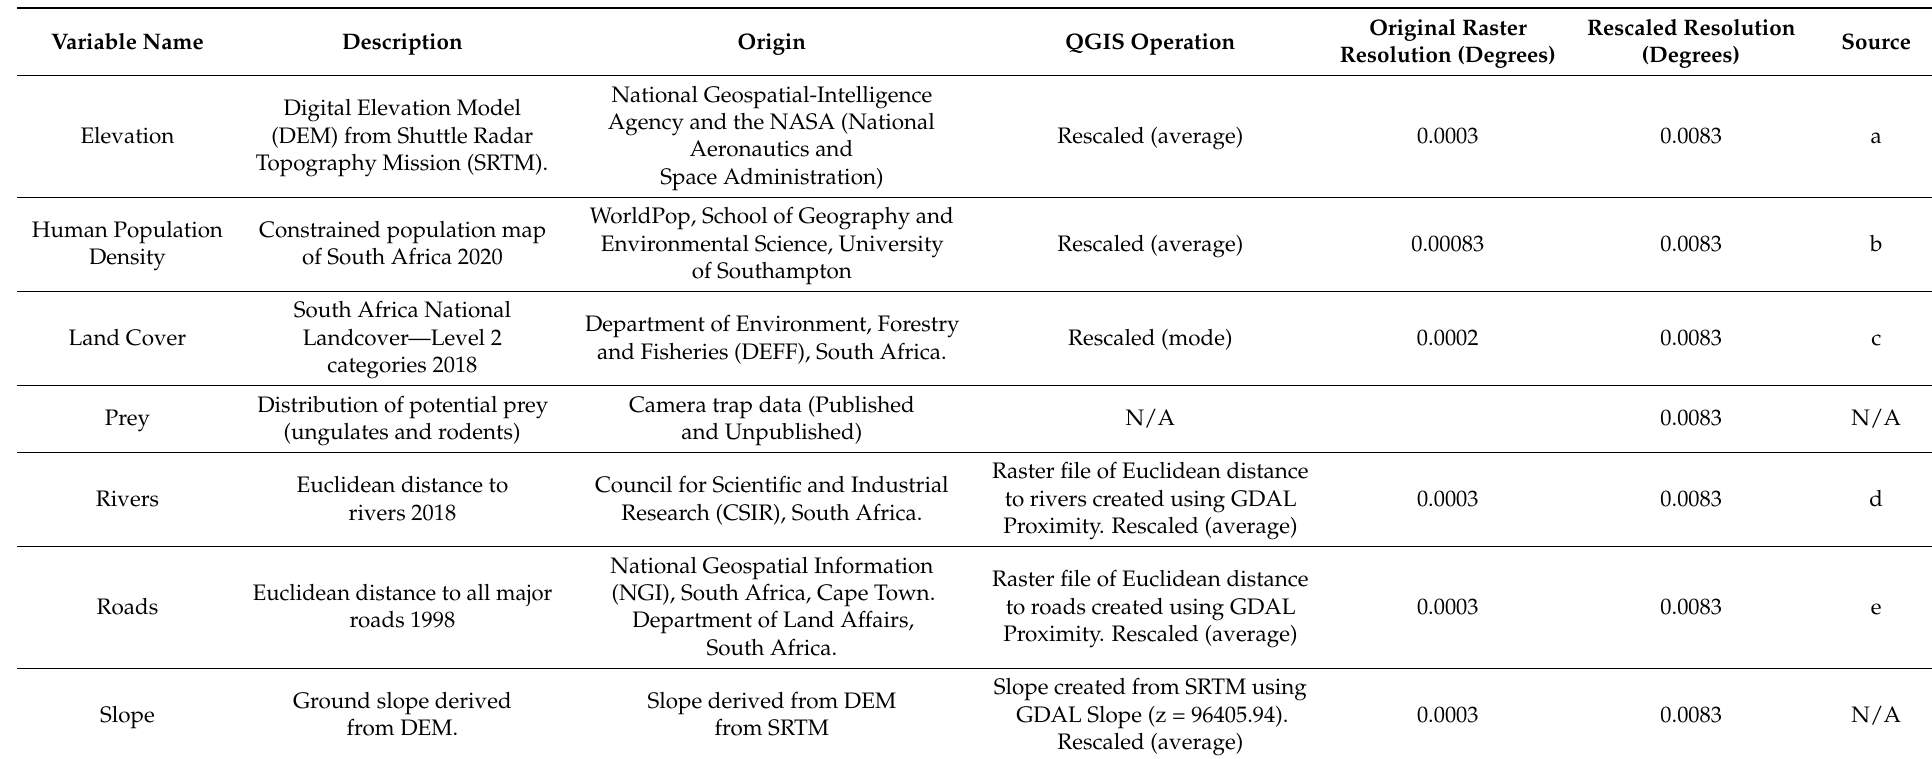
Table 2. Source of environmental variables used and methods of layer manipulation for habitat prediction